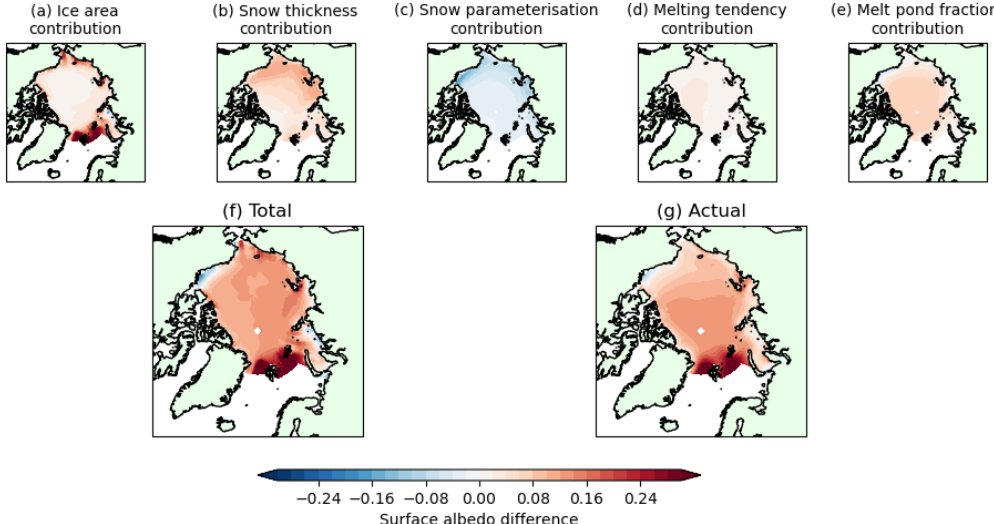
Figure 5. Components of June surface albedo difference for UKESM1.0-LL relative to HadGEM2-ES (1980–1999, averaged over all ensem- ble members). Shown are estimated surface albedo difference due to (a) ice area difference, (b) snow thickness difference, (c) the different snow area parameterisations used by the two models, (d) difference in surface melting tendency or the proportion of time during which surface melting conditions were present, and (e) the different melt pond parameterisations used by the two models. Panel (f) shows the total surface albedo difference produced by all components, and (g) shows the actual surface albedo difference between the two models, diagnosed from downwelling and upwelling SW radiation, for